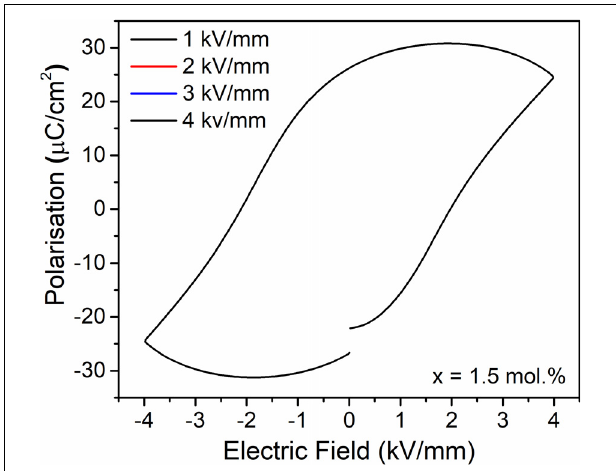
FIGURE 6 | P–E loop at room temperature for sample at x = 1.5 mol.%.